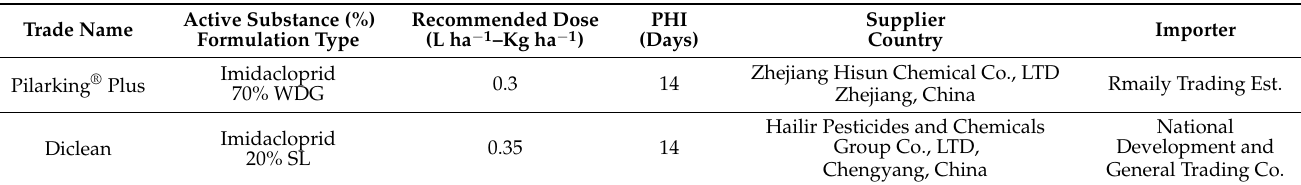
Table 3. Pesticides active ingredients and phytosanitary commercial products used for the experi- mental treatment of